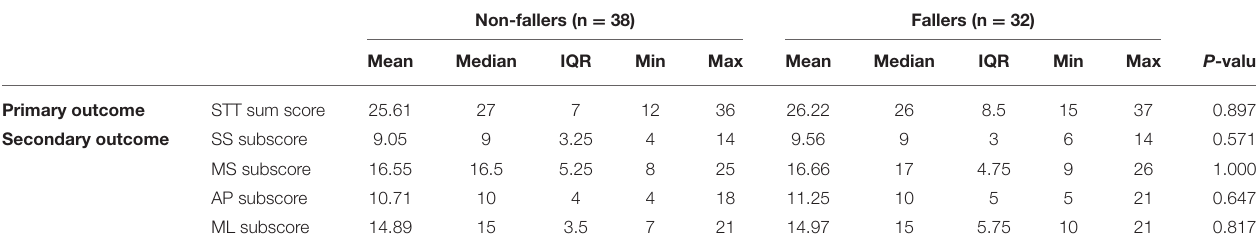
TABLE 5 | Differences between non-fallers and fallers in the STT sum scores (ACE).